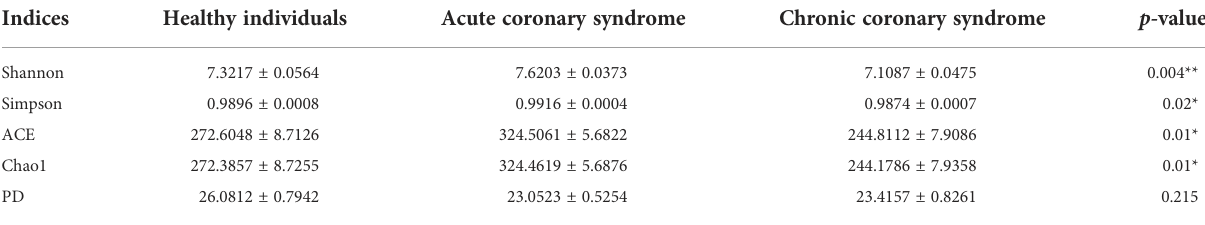
TABLE 3 The comparison of blood microbiota alpha diversity between each